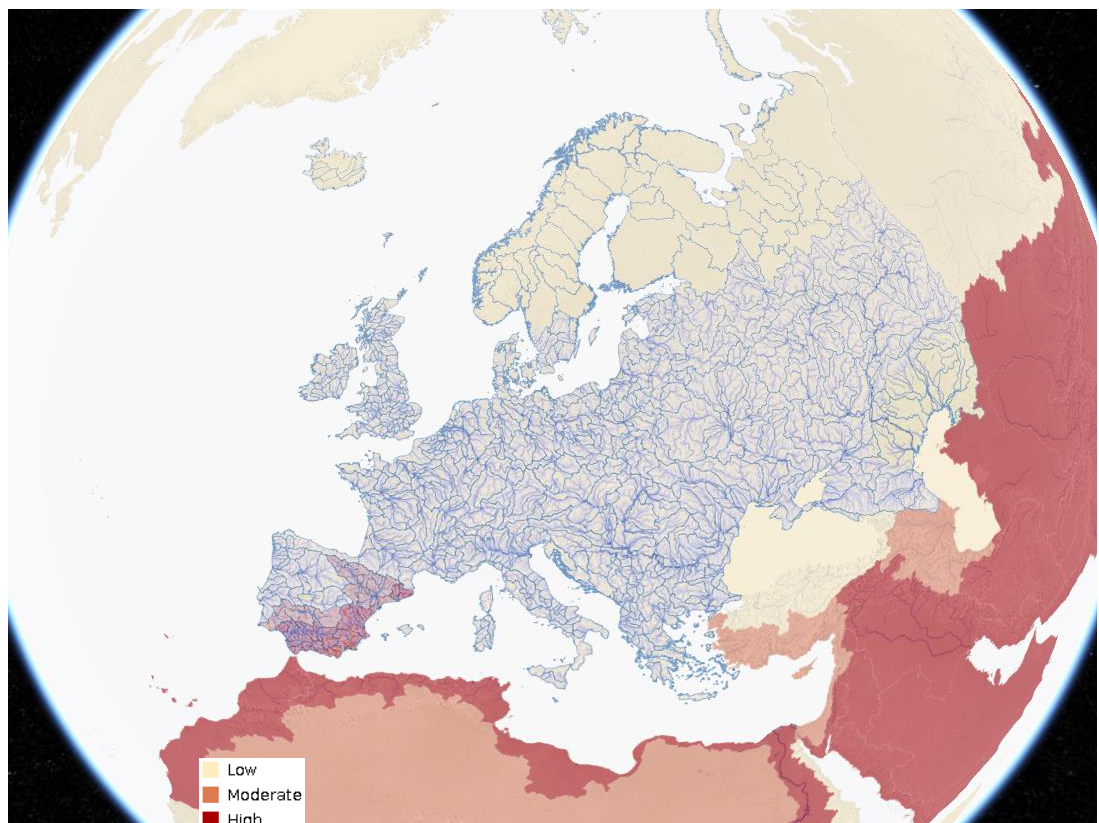
Figure 2. Distribution of physical water scarcity by major hydrological basin (global), and rivers and hydrological basins of EU countries (2021). Source: AQUASTAT maps [12].